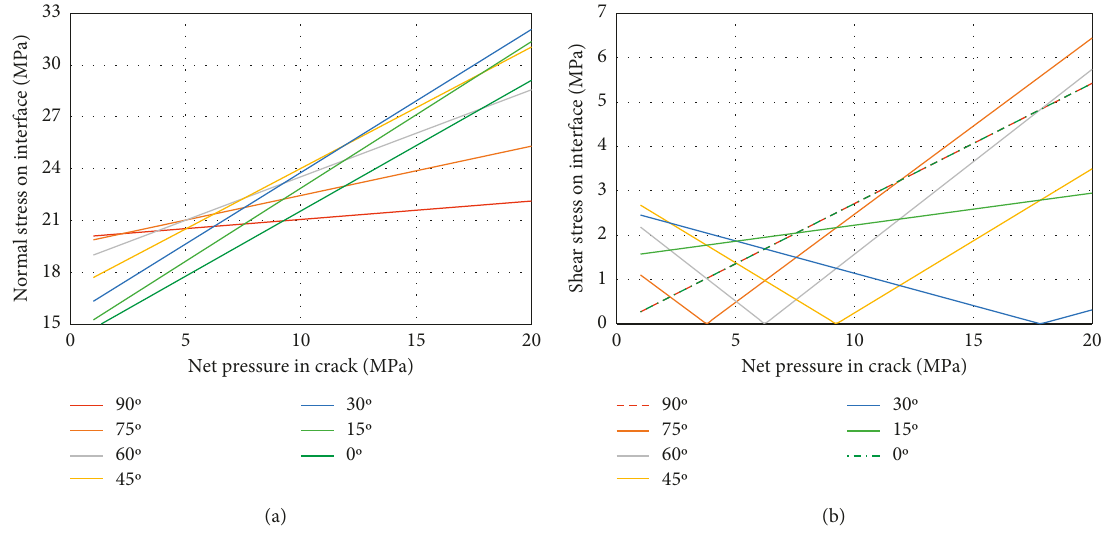
Figure 17: Stress curves on the structural plane: (a) normal stress; (b) shear